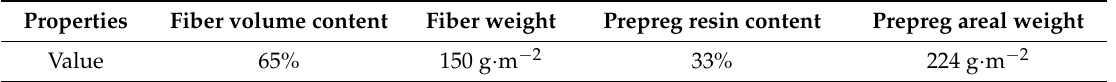
Table 1. Some typical properties of test prepreg.